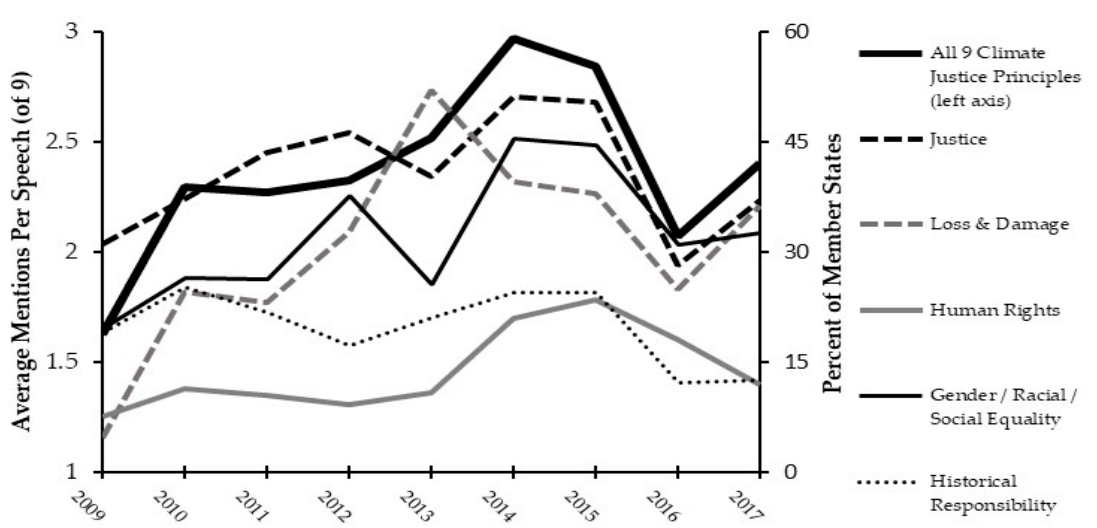
Figure 3. Mentions of Climate Justice Principles in United Nations Framework Convention on Climate Change (UNFCCC) Member Statements.